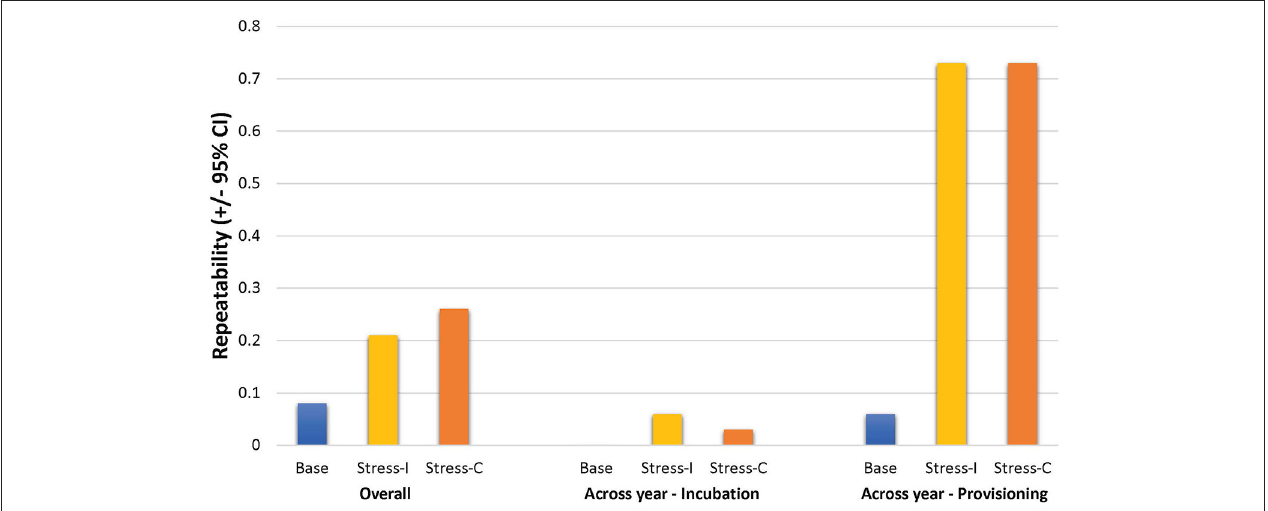
FIGURE 3 | Estimates of glucocorticoid repeatability in female tree swallows. Bar chart shows overall repeatability (all available samples), and across-year repeatability during the incubation and provisioning periods for baseline corticosterone (“Base”), the stress-induced increase in corticosterone (“Stress-I”) and circulating stress-induced levels